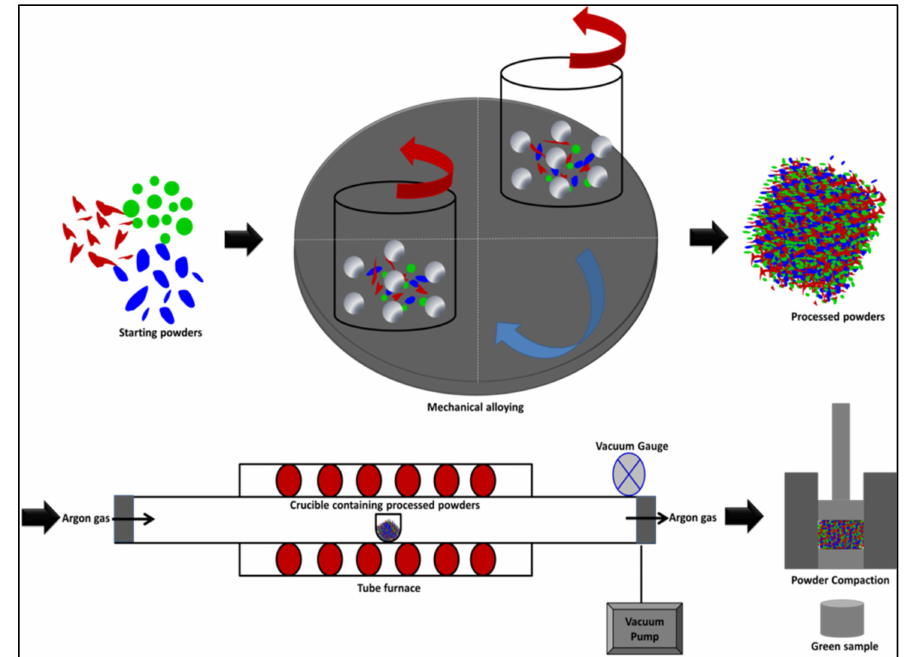
Figure 1. A schematic representation of the powders processing and compaction in this